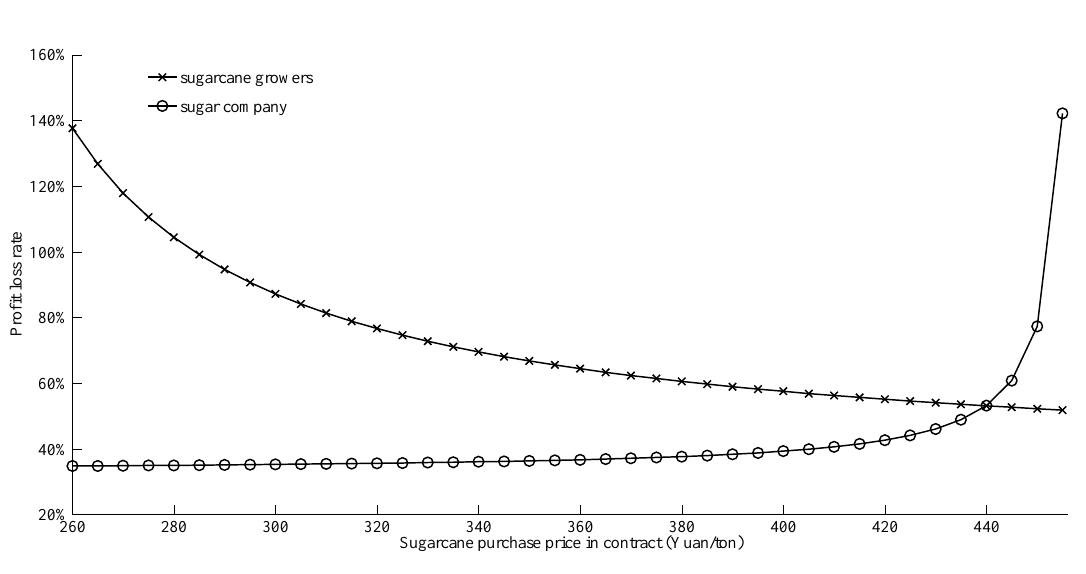
Figure 5. Impact of natural disaster severity on the profit loss rate.